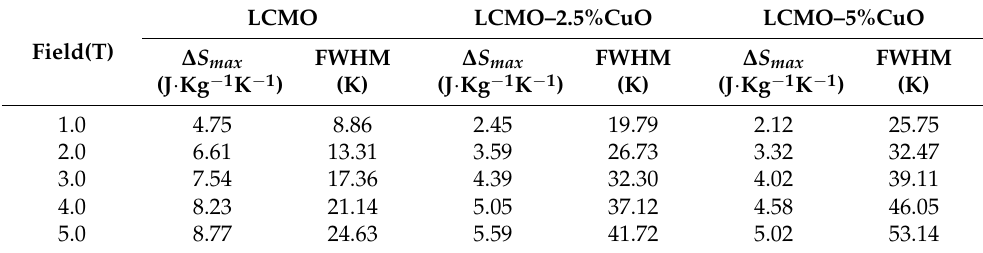
Table 5. Magnetic field dependence of maximum entropy change. and FWHM of LCMO–CuO composite samples.